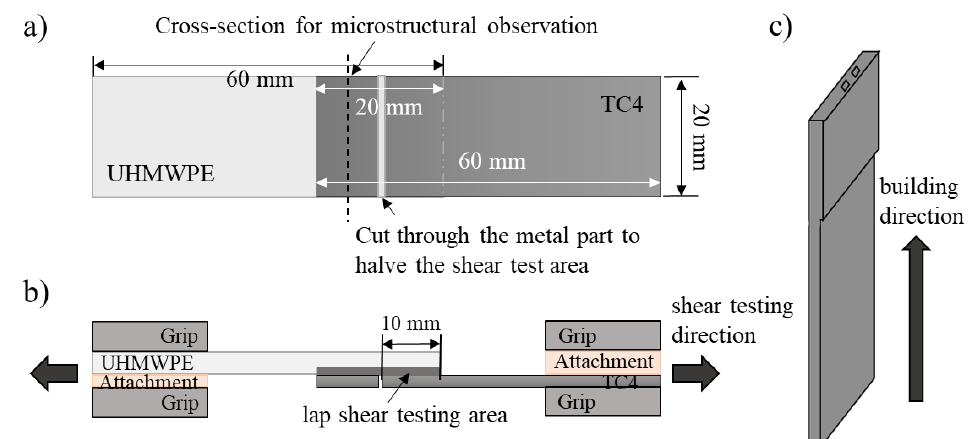
Figure 4. Schematic diagrams showing: ( a ) cross-section cut; ( b ) lap shear testing; ( c ) building direction of electron beam melting (EBM) processing.